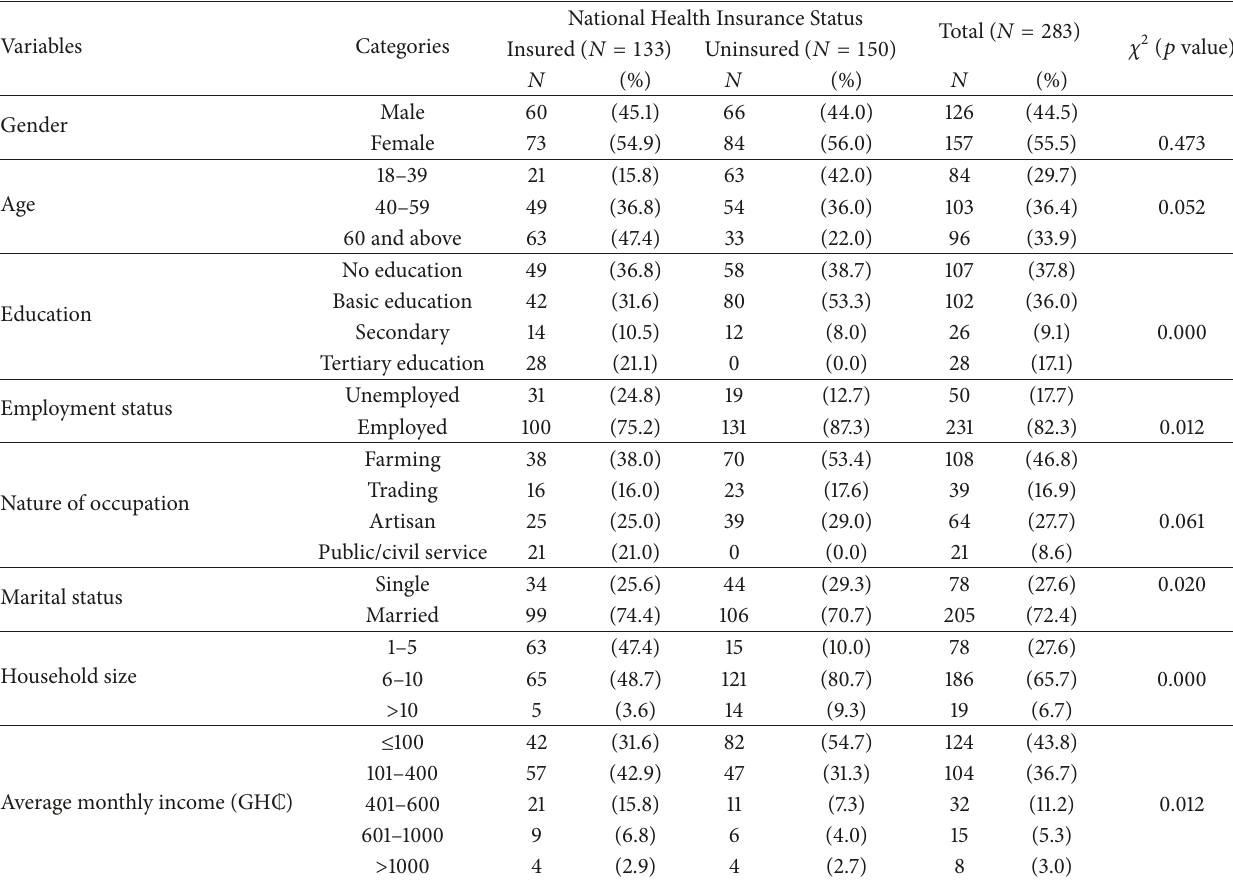
Table 1: Background characteristics of study participants by health insurance status.